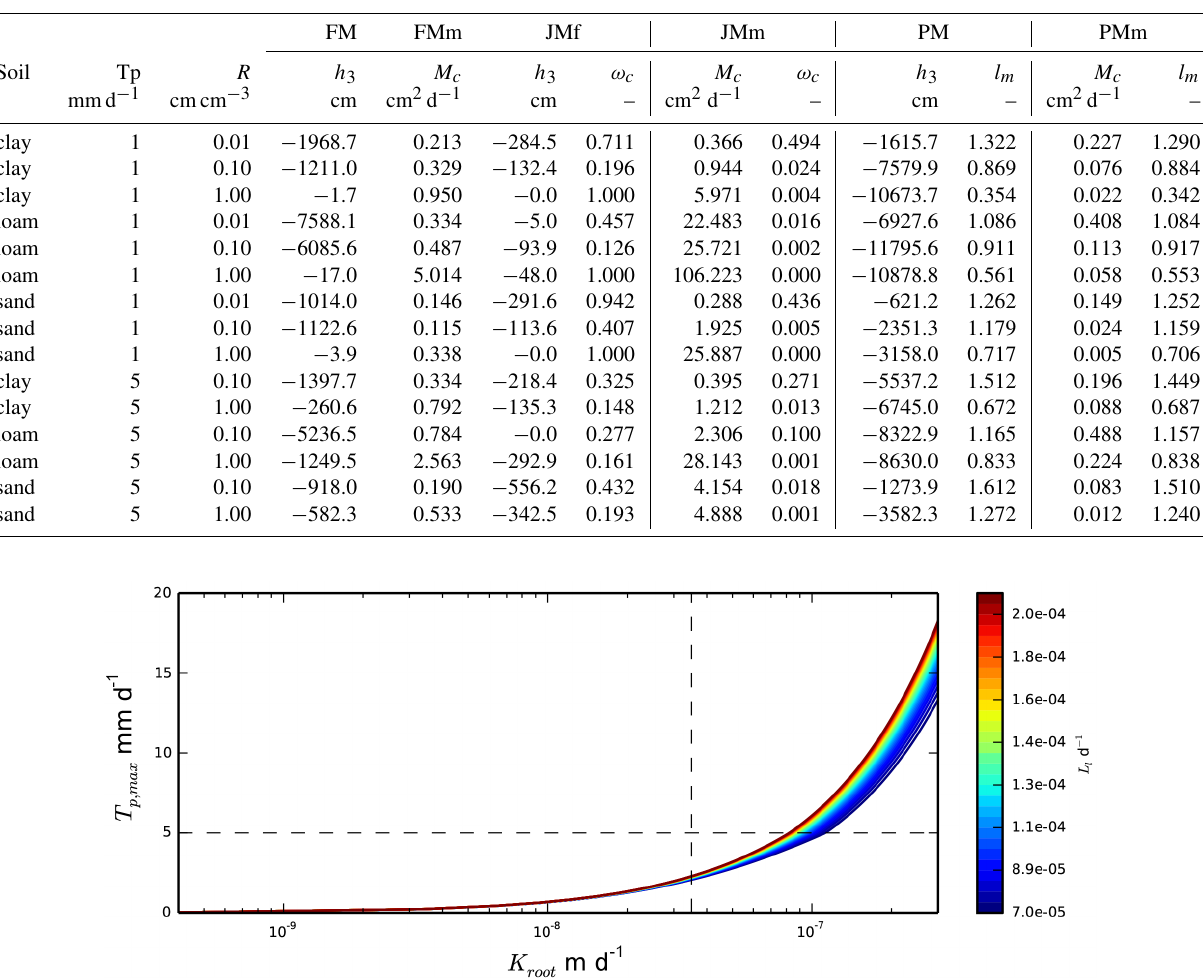
Table 5. Optimal parameters of each empirical model for all scenarios in the drying-out experiment.